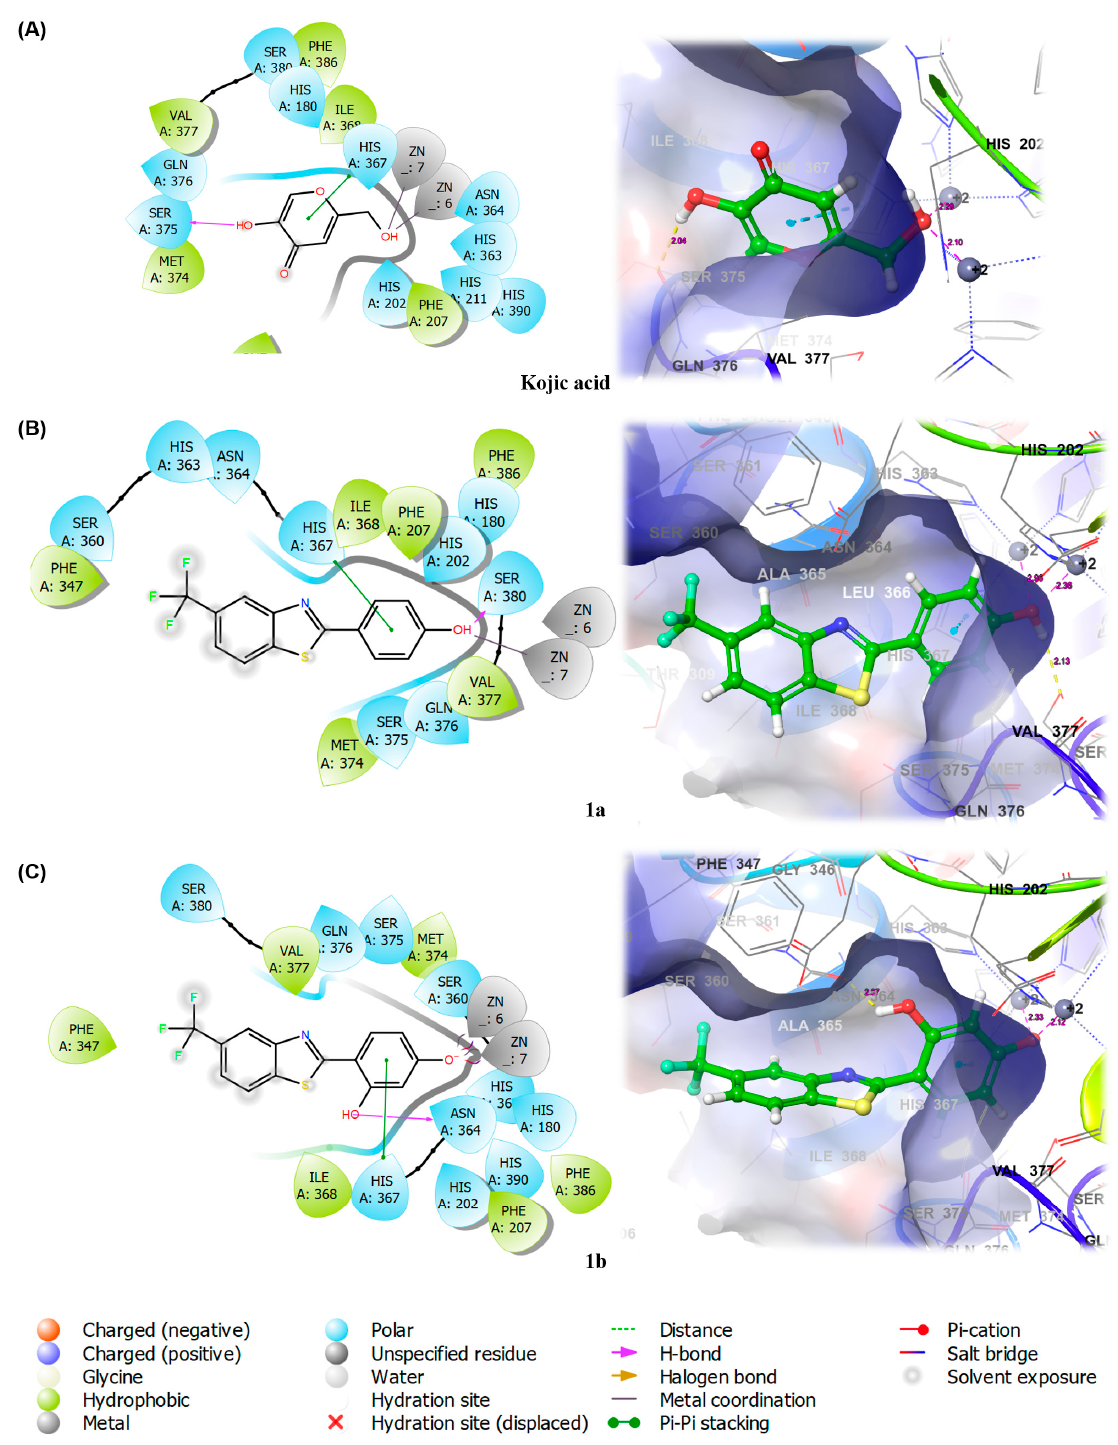
Figure 6. Binding interactions between the human tyrosinase homology model and compounds 1a , 1b , or kojic acid. 1b , or kojic